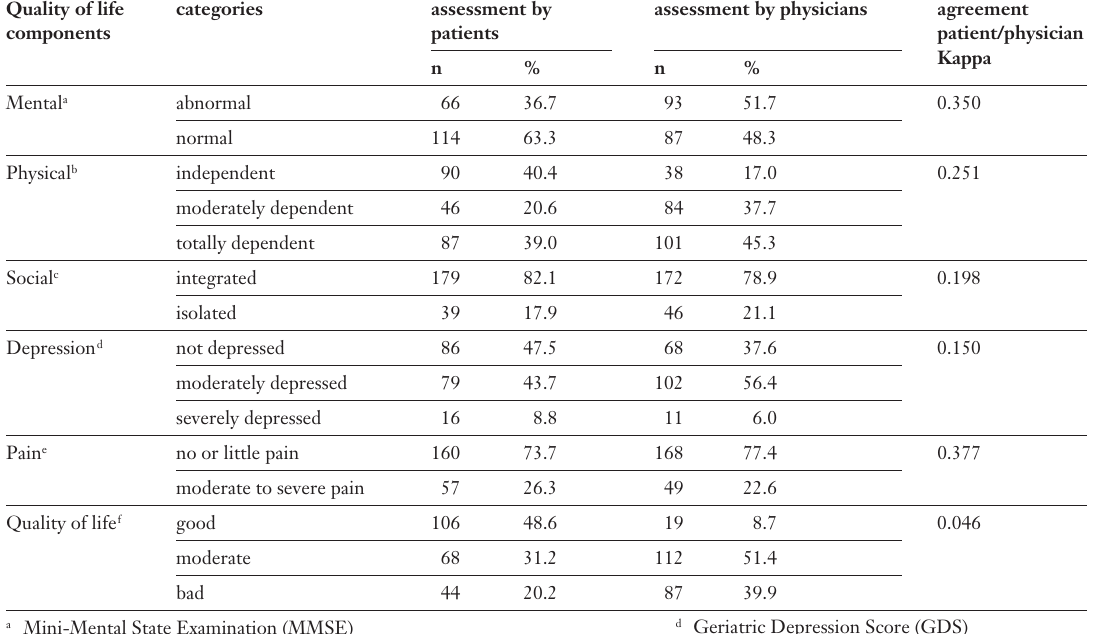
Table 2 Quality of life compo- nents and global quality of life values as assessed by Do- Not-Resuscitate (DNR) patients and their physicians as well as patient/ physician agreement about different func- tionalities and quality of life. La Chaux-de- Fonds, Switzerland,